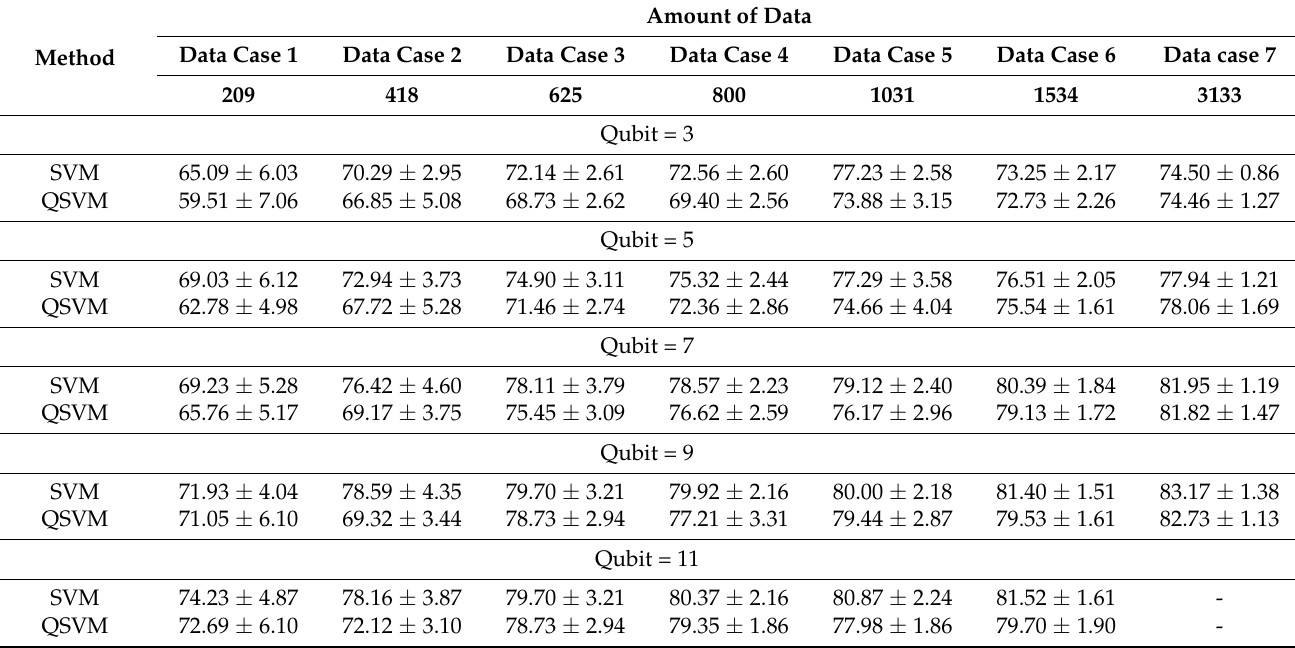
Table 2. Accuracy rates with mean and standard deviations for QSVM and SVM classi fi er.